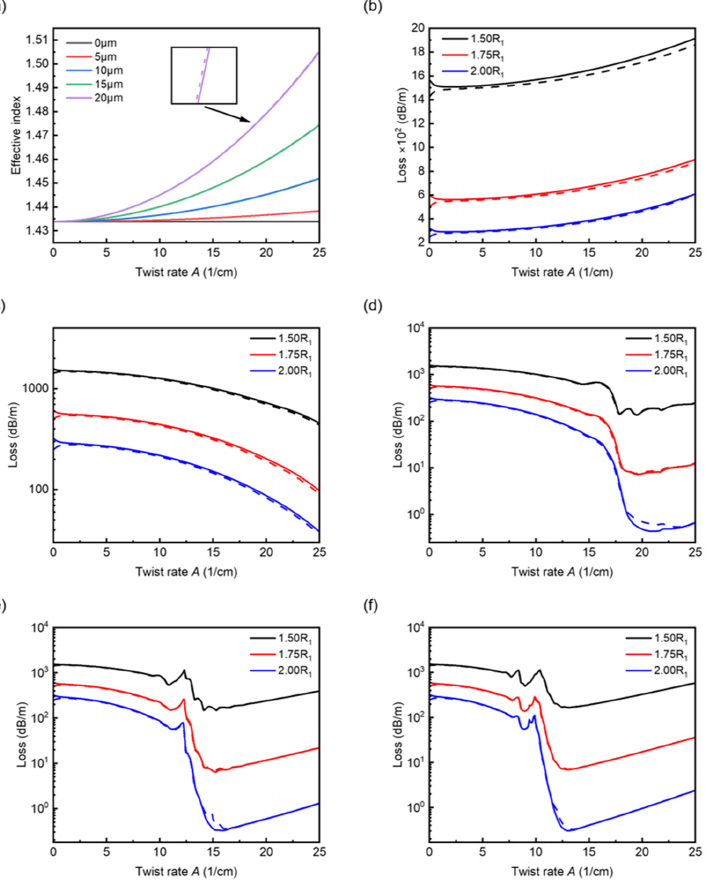
Figure 4. Effective indices and loss spectra of the HE − (solid lines) and HE + (dash lines) fundamental modes for n a = 1.33 with five core offsets. ( a ) Effective indices versus twist rate with R 2 = 1.5R 1 . ( b – f ) Loss spectra for core offsets ρ = 0, 5, 10, 15 and 20 µ m with R 2 /R 1 varying from 1.5 to